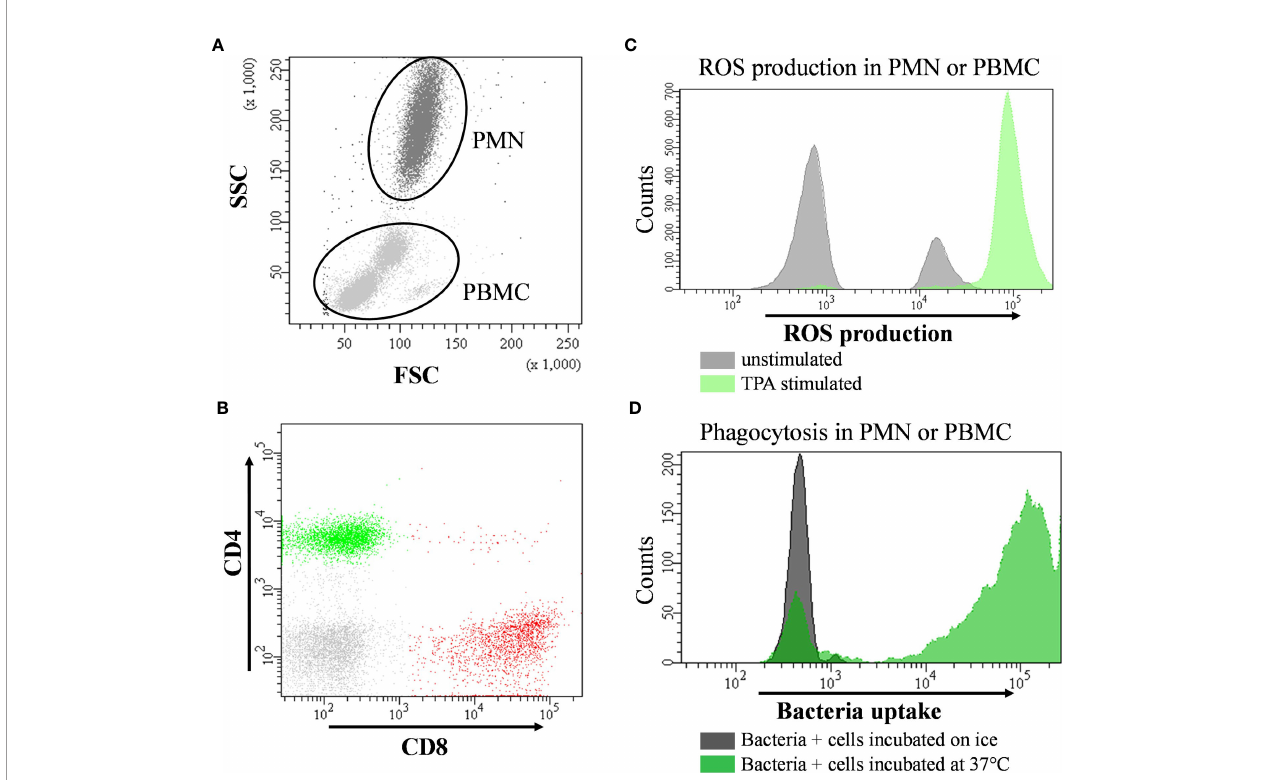
FIGURE 2 | Representative fl ow cytometry images and hierarchical gating strategies for leukocyte subsets in bovine peripheral blood. (A) for the phagocytosis assay cells were fi rst gated for peripheral blood mononuclear cells (PBMC) and polymorphonuclear cells (PMN) according to their morphological properties using forward (F-) and side (S-) scatter (-SC) settings. To distinguish cells from bacteria, DNA content was used for de fi nition (small histogram). Percentage of phagocytosing PBMC or PMN were determined by its green fl uorescence after 10 min incubation at 37°C (far right dot plot) and. (B) PBMC were analyzed for expression pattern of speci fi c surface marker using fl uorochrome conjugated speci fi c monoclonal antibodies (CD4 and CD8 presented as example) allowing the identi fi cation and quanti fi cation of lymphocyte subsets. (C) overlay histogram demonstrating the shift of fl uorescence of cells with or without 12-O-tetradecanoylphorbol-13-acetate (TPA) due to oxidation of dihydrorhodamine by intracellular reactive oxygen species (ROS). (D) overlay histogram illustrating the shift of fl uorescence of cells incubated with fl uorescence-labelled bacteria on ice (control) or at 37°C to quantify the extent of phagocytosing capacity. Phagocytosis as well as the capacity to form intracellular ROS were determined by analyzing the percentage of fl uorescent cells and by measuring their mean fl uorescence intensity